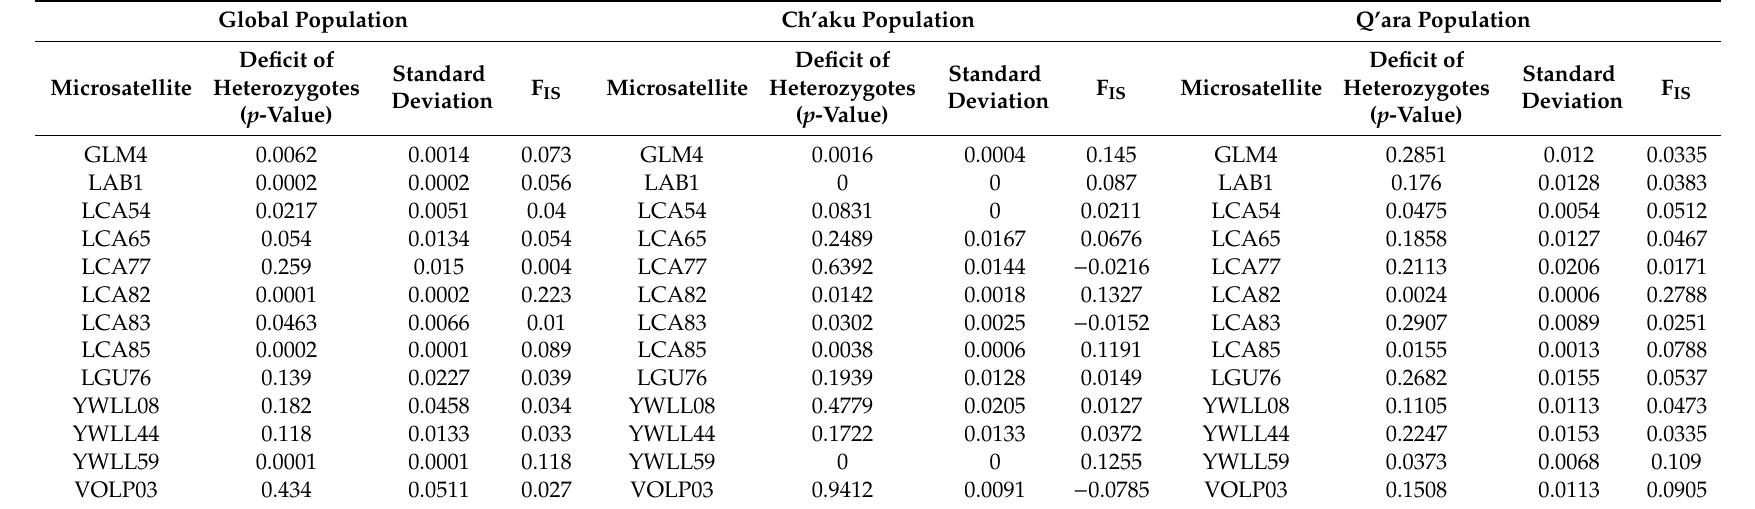
Table 2. Analysis of the Hardy–Weinberg equilibrium for each microsatellite of the global llama population of the Camelid Germplasm